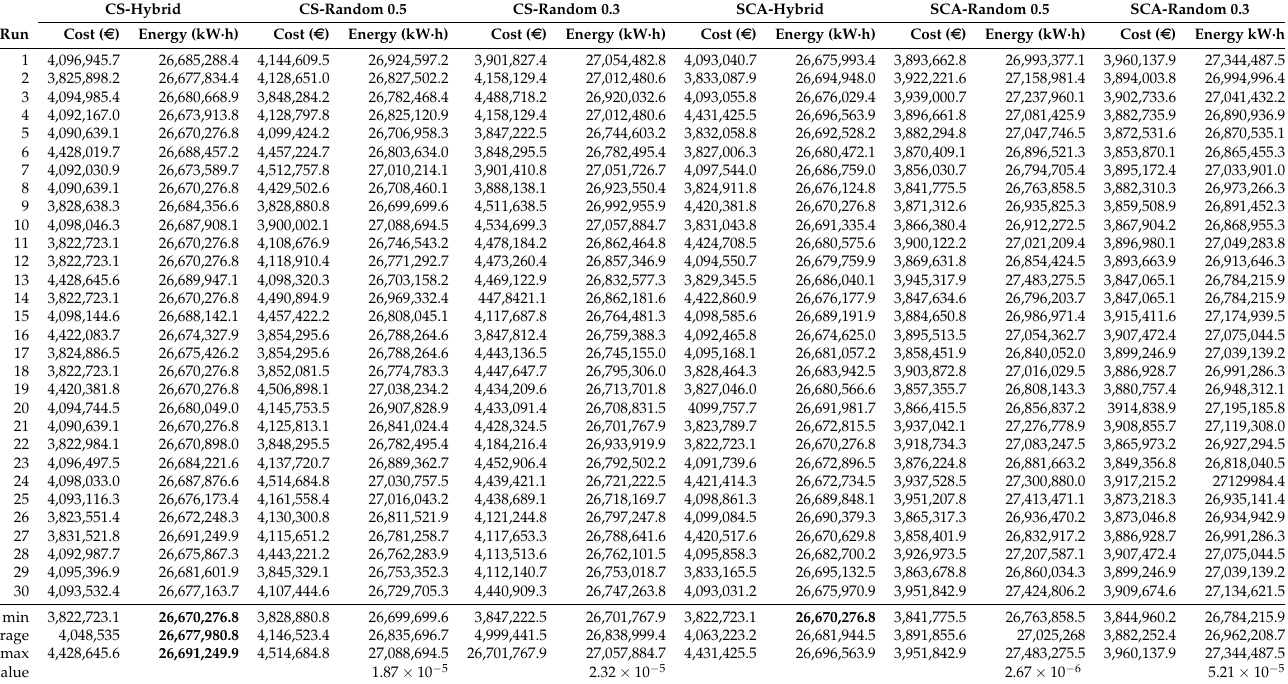
Table 6. Comparison of random with hybrid discretization algorithms in the embodied optimiza- tion